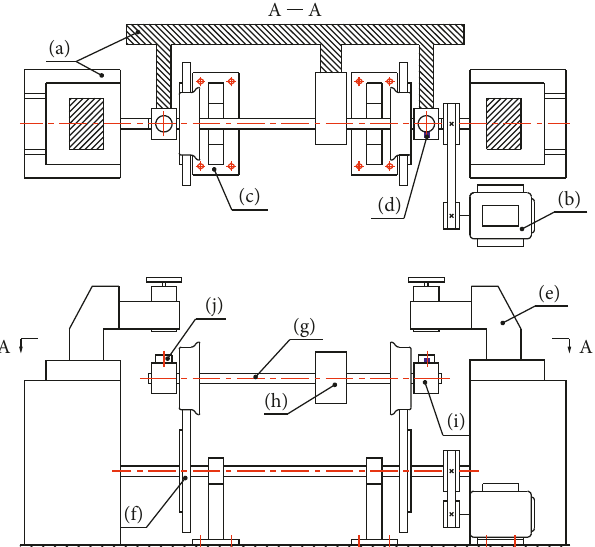
Figure 10: Schematic diagram of the bench test for a wheelset bearing: (a) fixing devices; (b) driving motor; (c) supporting seat; (d) accel- erometer; (e) loading device; (f) driving wheel; (g) wheelset; (h) gear box; (i) axle box; (j) rubber buffer.